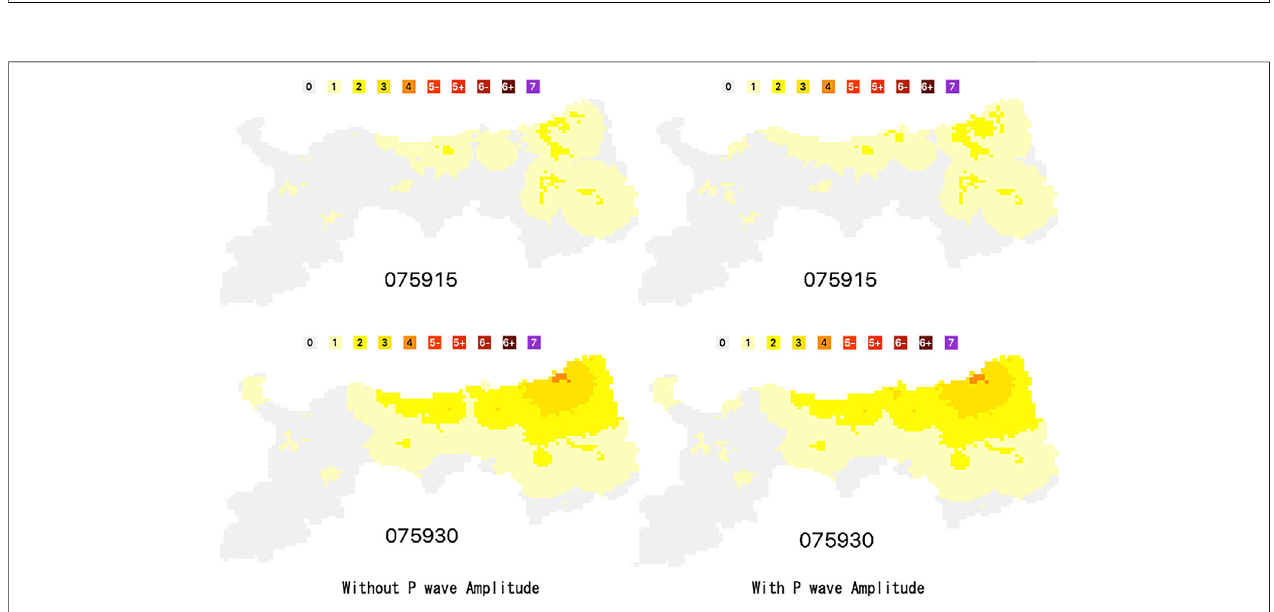
FIGURE 12 | Seismic intensity distribution of the 2018 Western Shimane Prefecture Earthquake interpolated by the JMA considering the site ampli fi cation factor (modi fi ed from the Japan Meteorological Agency, 2018).